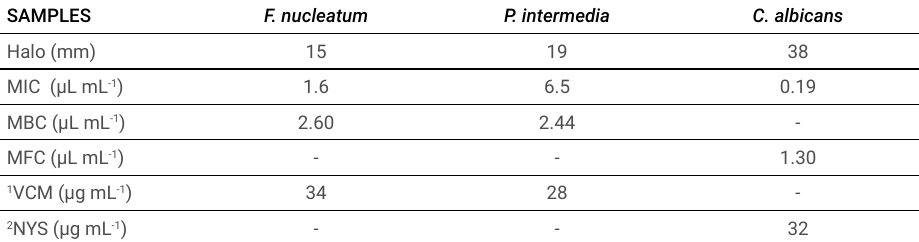
Table 2. Inhibition zone diameter, antimicrobial and antifungal activities of Lippia thymoides essential oil.